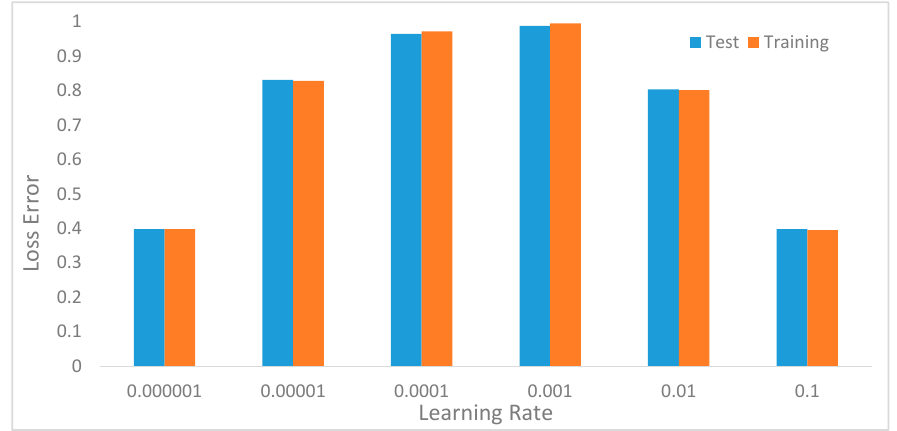
Figure 15. Model recognition accuracy of the model with various values of learning rates.